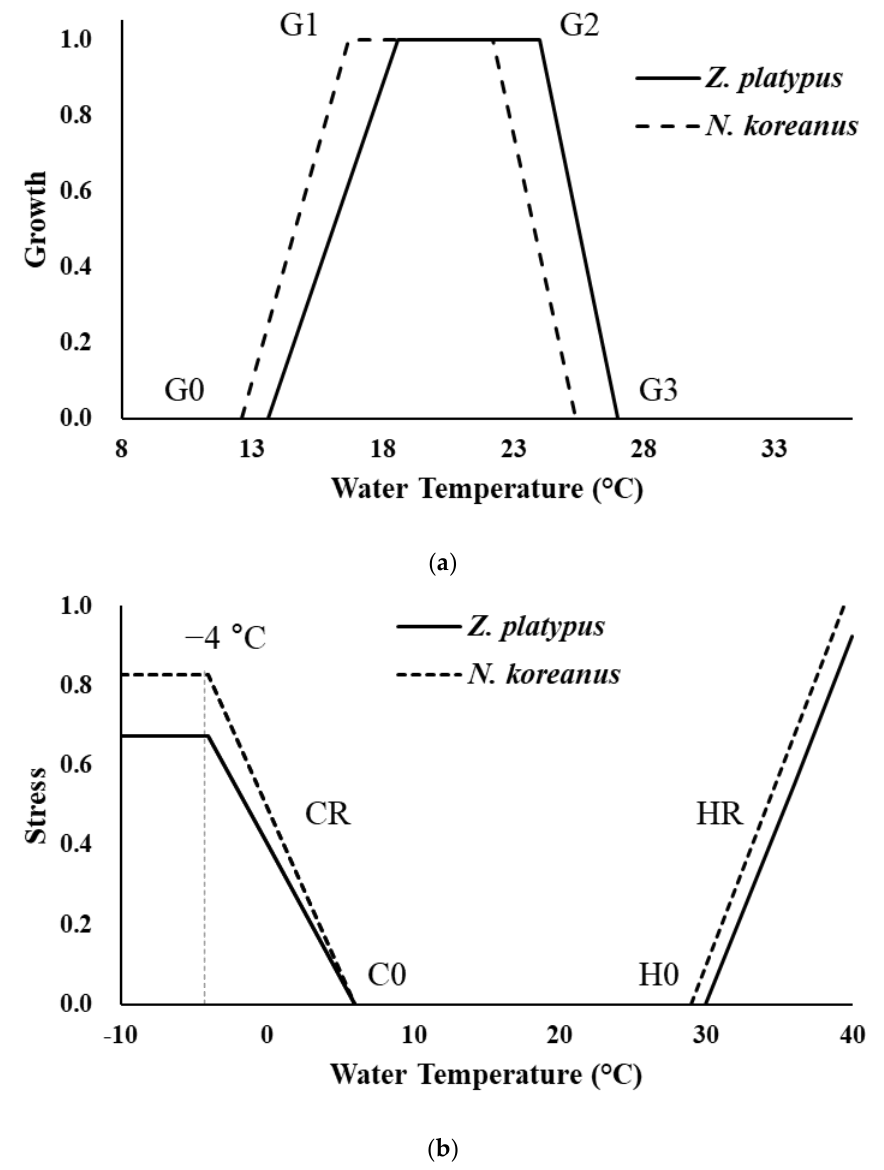
Figure 3. Physiologic suitability curves for Zacco platypus and Nipponocypris koreanus : ( a ) growth and ( b ) cold and heat stress. The lower (G1) and upper (G2) optimum temperatures for growth were set as 1 and the lower (G0) and upper (G3) threshold temperatures for growth were set as 0. The threshold for cold (C0) and heat (H0) stress were set as 0. The cold stress rate (CR) and heat stress rate (HR) are the slope of cold and heat stress curves, respectively. It was assumed that cold stress is not increased below − 4.0 °C.